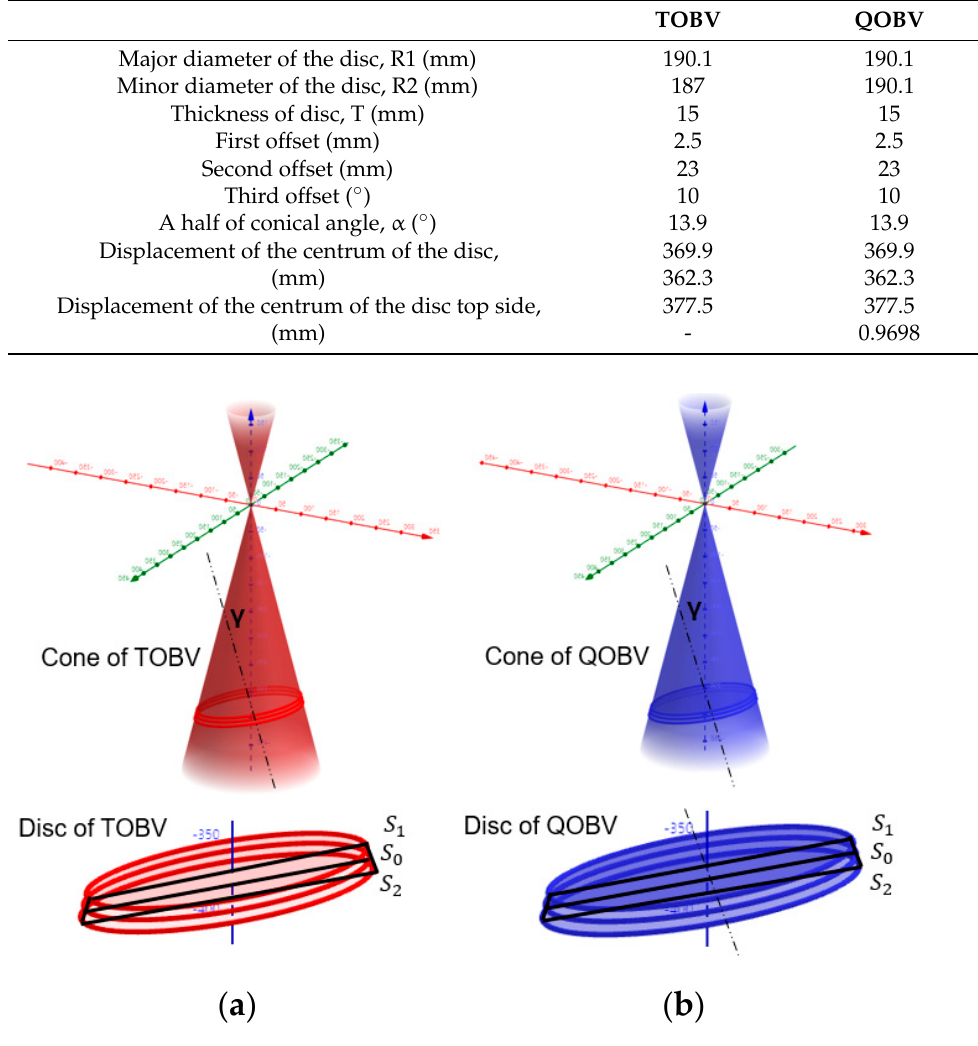
Figure 8. Generation of seal cone and disc: ( a ) TOBV; ( b ) QOBV. The elliptical seal cone of QOBV has a circular disc with a diameter of 190.1 mm, as shown in Figure 9. The disc area of QOBV is 28,382.7 mm 2 , which is larger than that of TOBV, 27,924.4 mm 2 . This means the flow rate of QOBV is improved compared to that of